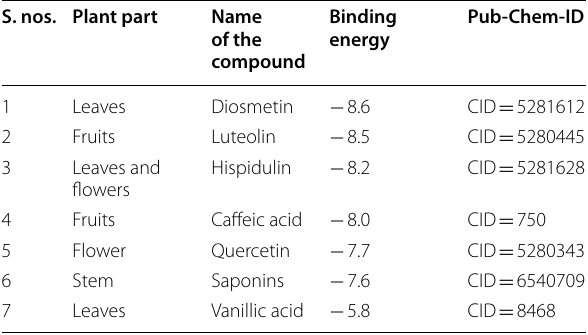
Seven compounds with binding energies between have been shortlisted on the docking-based screening using PyRx software